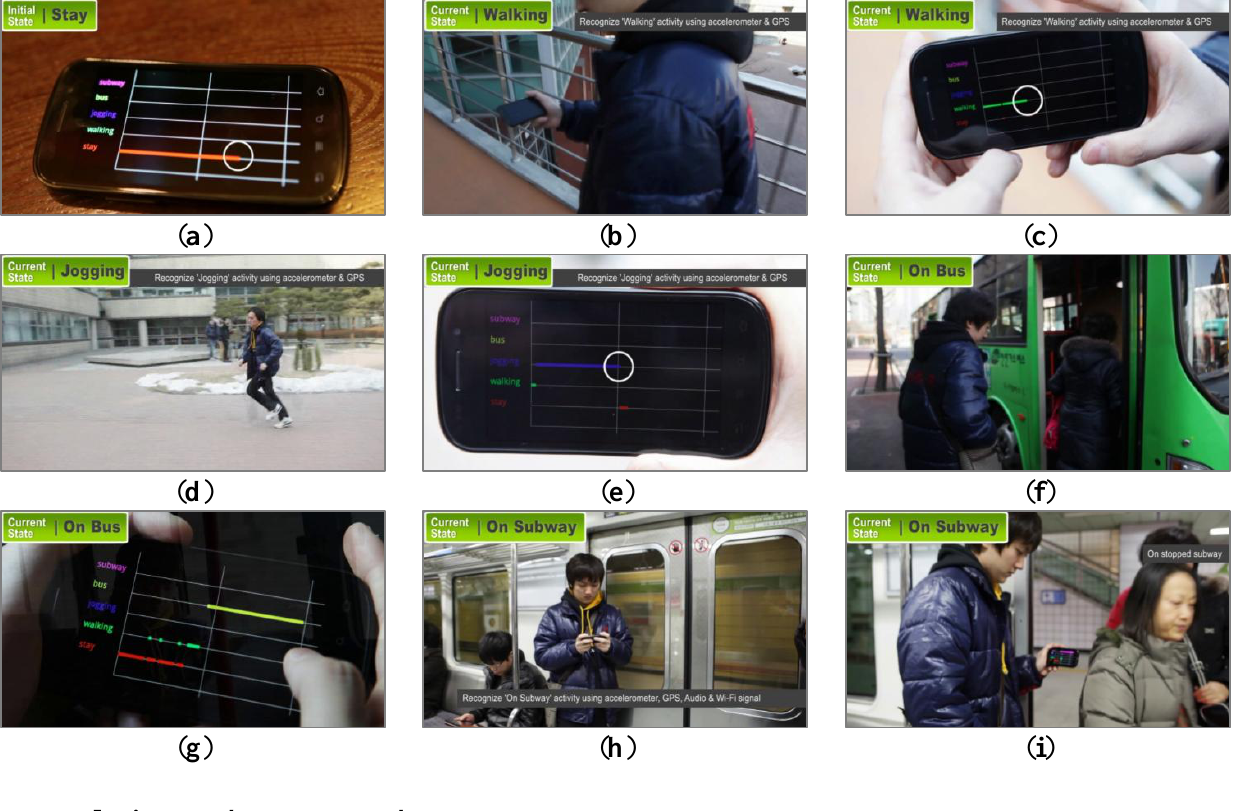
Figure 6. Demonstration of the integrated system via testing in a real-world